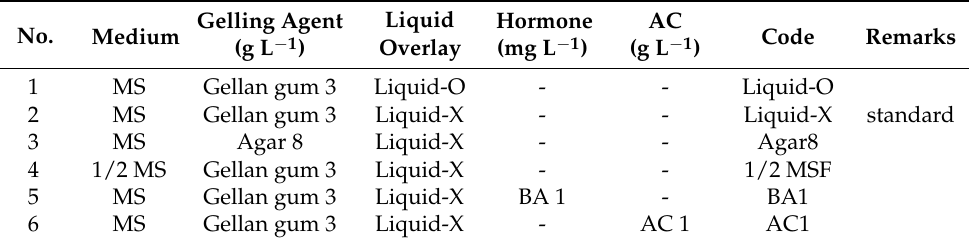
Table 3. Set of treatments to test the impact of subculture medium and conditions in S-0 cycle for five weeks on the growth of donor plantlets and regrowth of cryopreserved P. yatabeanus shoot tips.